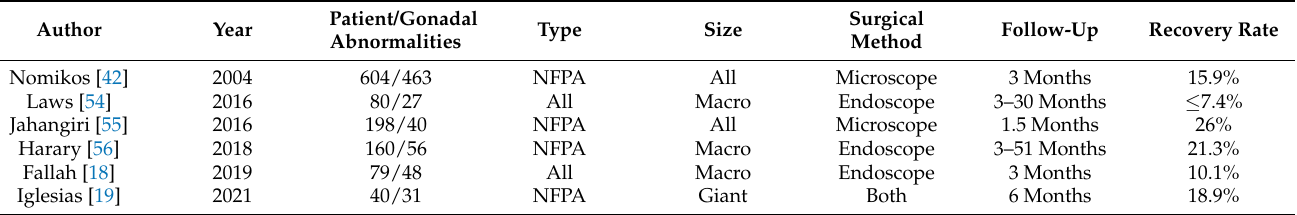
Table 1. Overview of male gonadal function recovery after transsphenoidal surgery in the